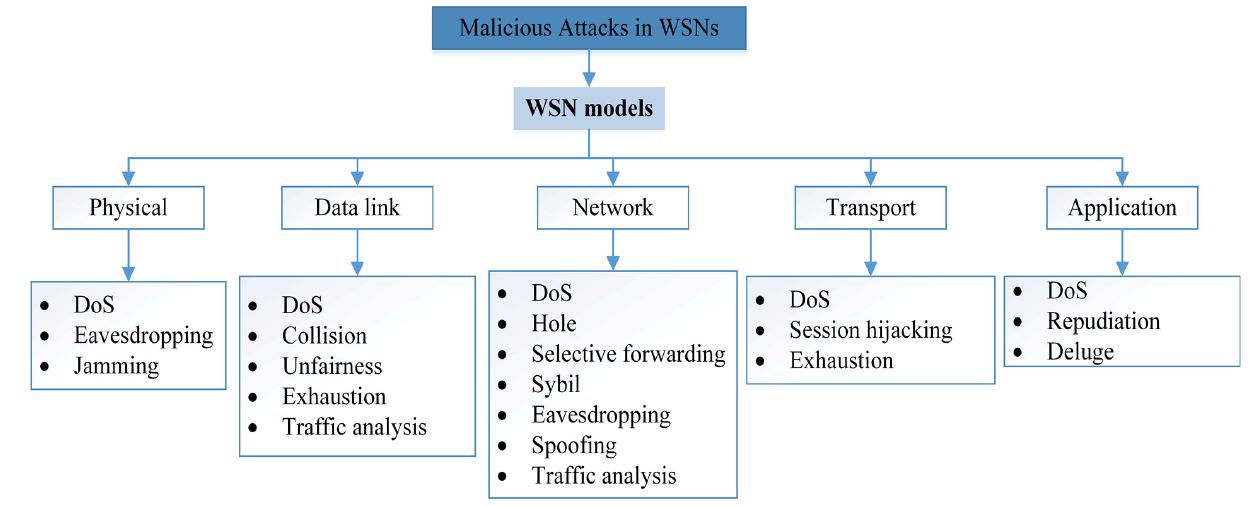
Figure 5. Malicious attacks classifications .